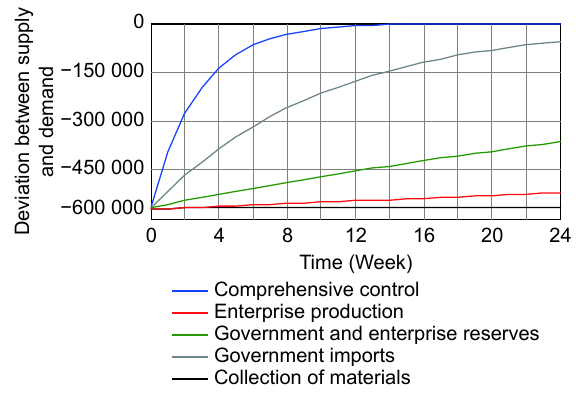
Fig. 9 Comparison of the supply and demand deviation under different control strategies.